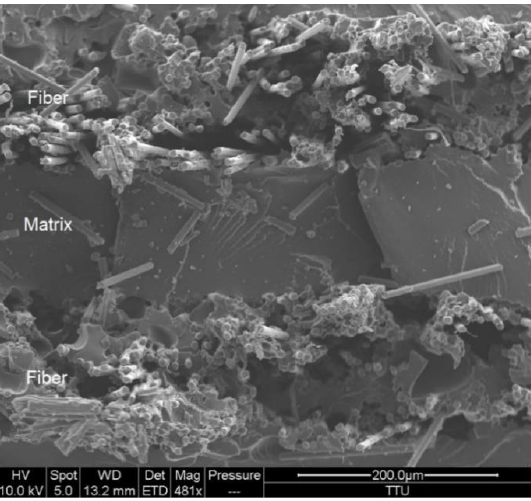
Figure 16. Fiber breakage and fiber pull out and voids of fractured specimen of nylon-CF.